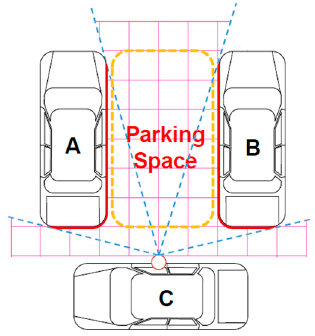
Figure 14. Vertical parking mode.